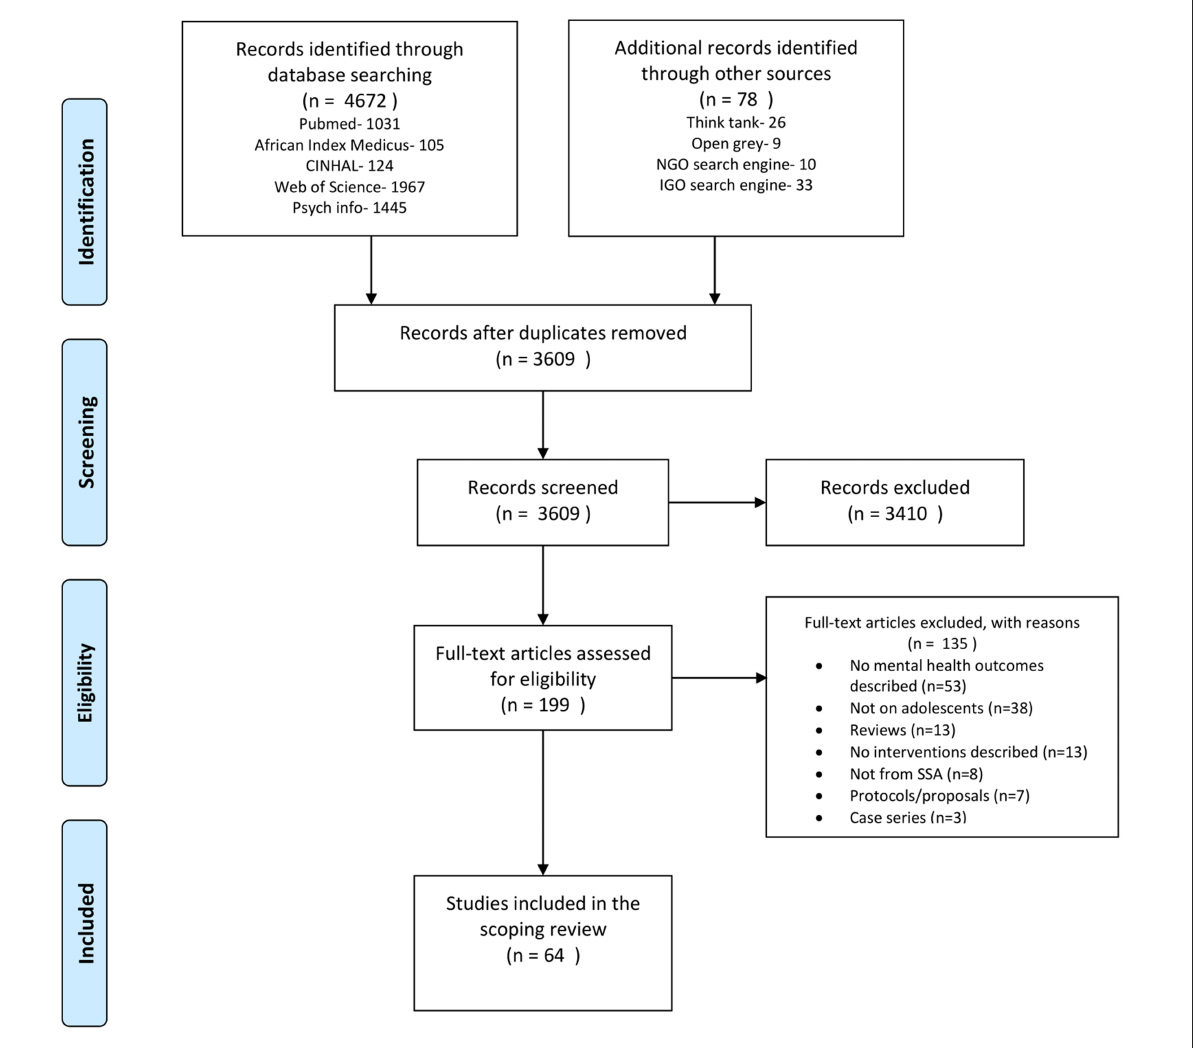
FIGURE1 Flowchart showing the scoping review